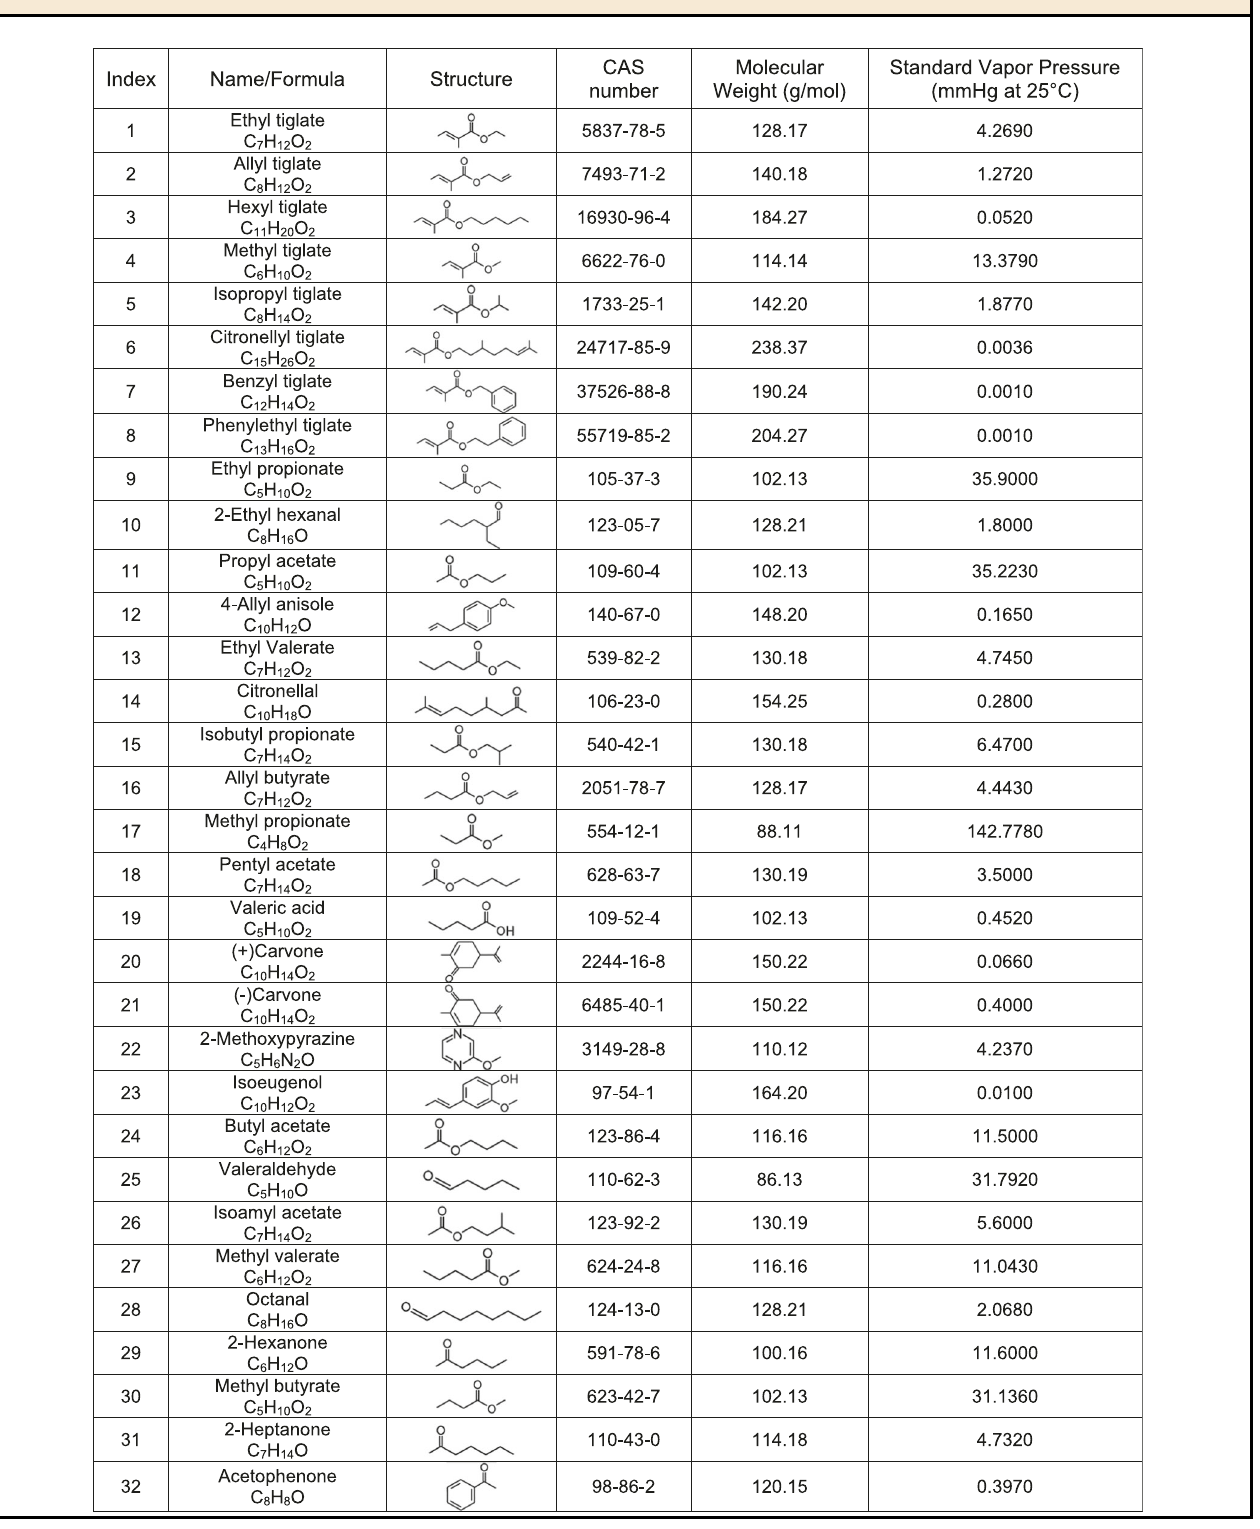
Table 3 Odor information related to Figs. 5 and 7